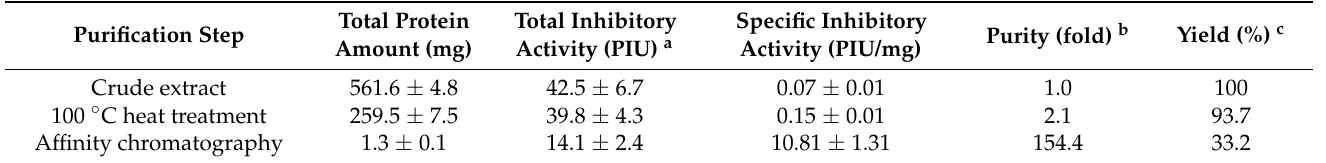
Table 2. Purification steps of MoPI from Moringa oleifera seeds.